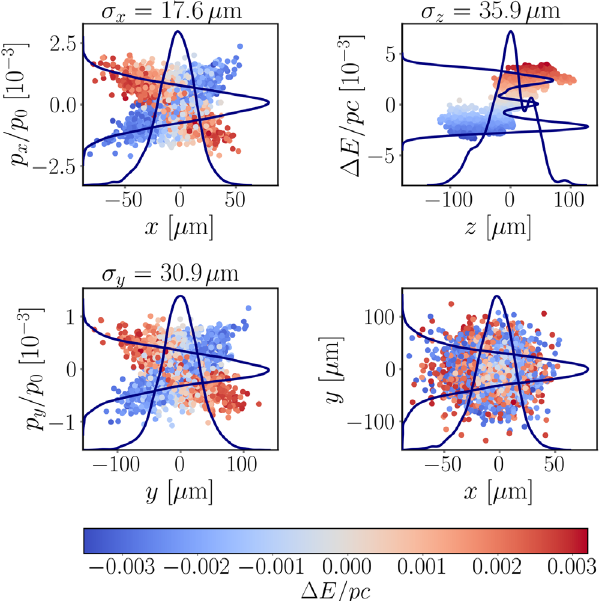
FIG. 3. 2D projections of the distribution of a bunch tracked through the transfer line to the plasma injection point. The color of the data points denotes the Δ E=pc value.